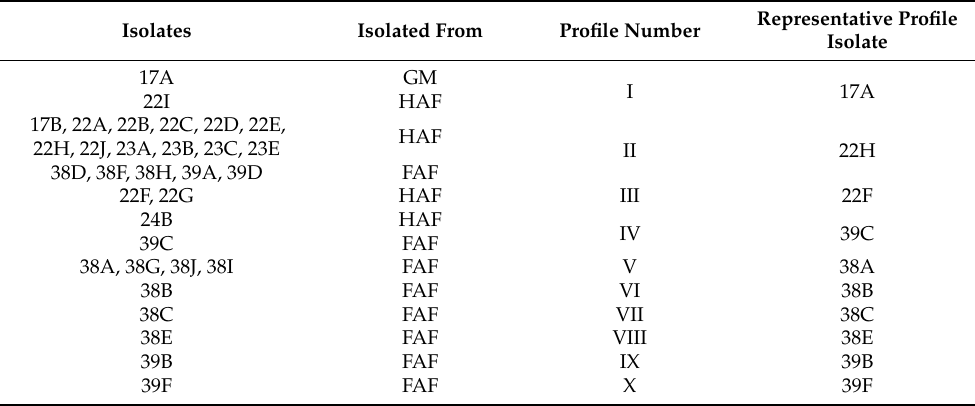
Table 1. S. cerevisiae yeasts isolated from industrial Garnacha Pago wine: isolate name, origin, mDNA HinfI profile, and representative profile isolate. The right column describes the isolate that represents each mDNA pattern. GM: Grape must; HAF: Halfway (middle) through alcoholic fermentation; FAF: End of alcoholic